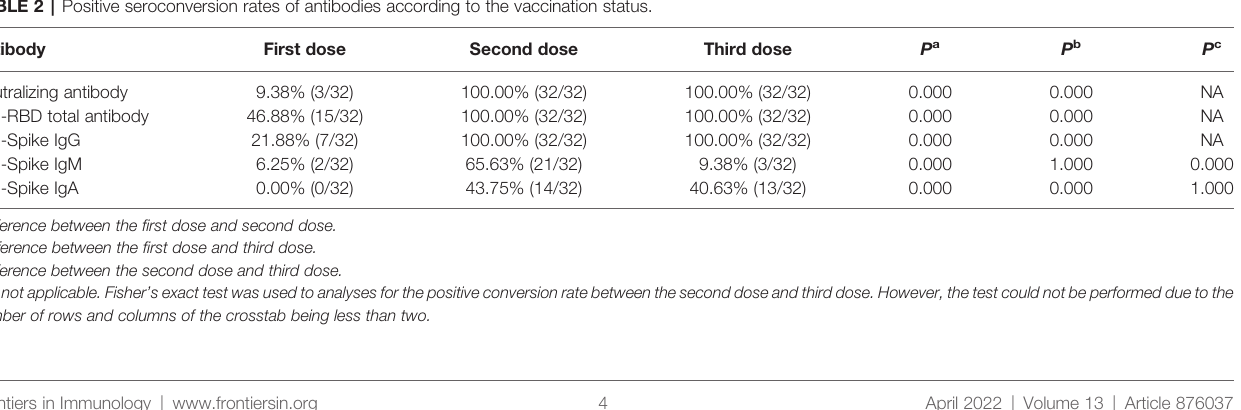
TABLE 2 | Positive seroconversion rates of antibodies according to the vaccination status. Antibody